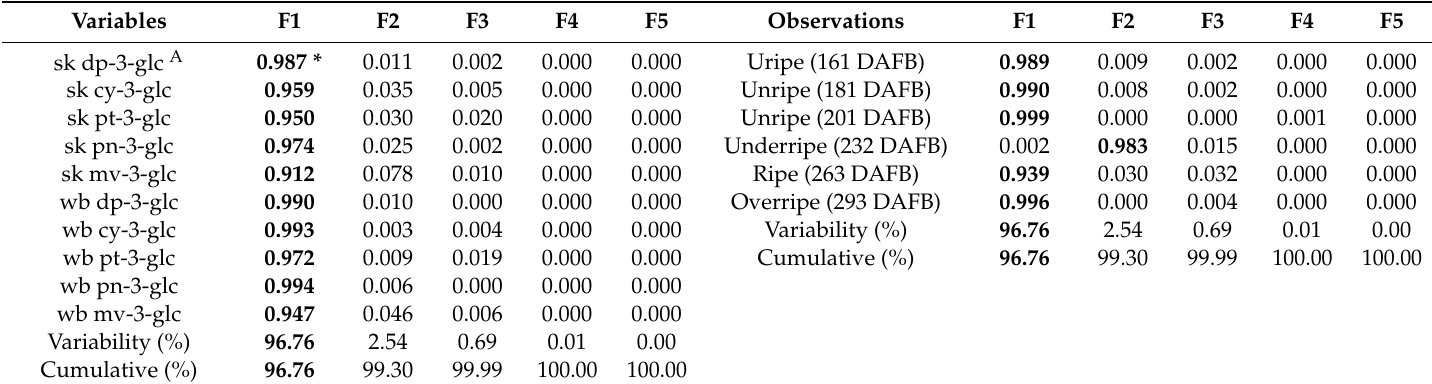
Table 4. Matrix of dominant rotated factor (F) loadings on anthocyanin concentration (mg / kg fw) in the skin and whole berry in black ‘Isabel’ grape during berry